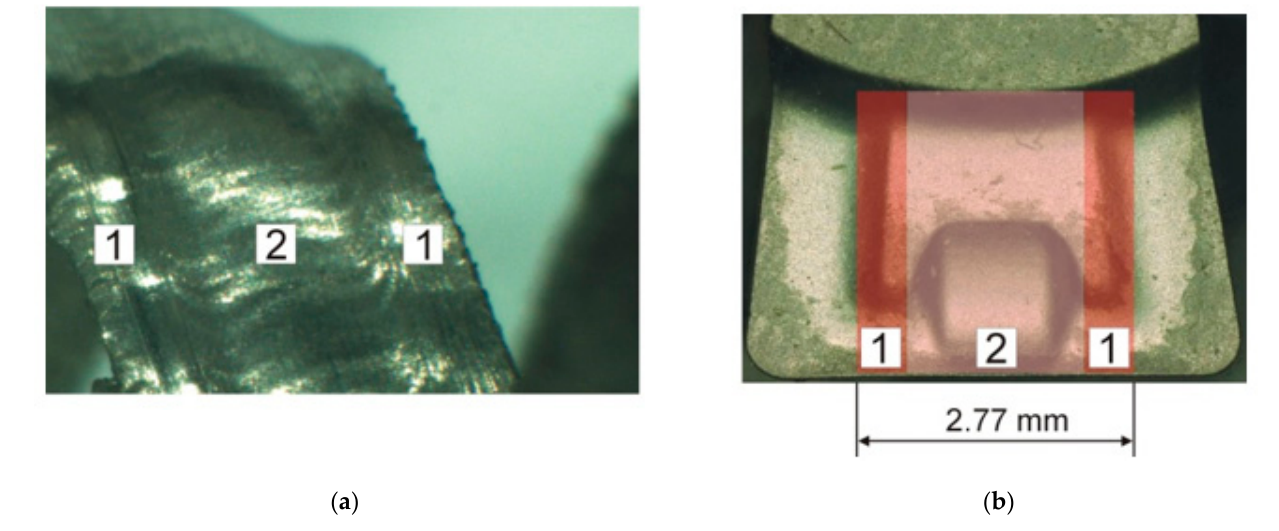
Figure 4. ( a ) Characteristic areas 1 and 2 on the chip surface and ( b ) corresponding areas on the rake face of the insert [36].